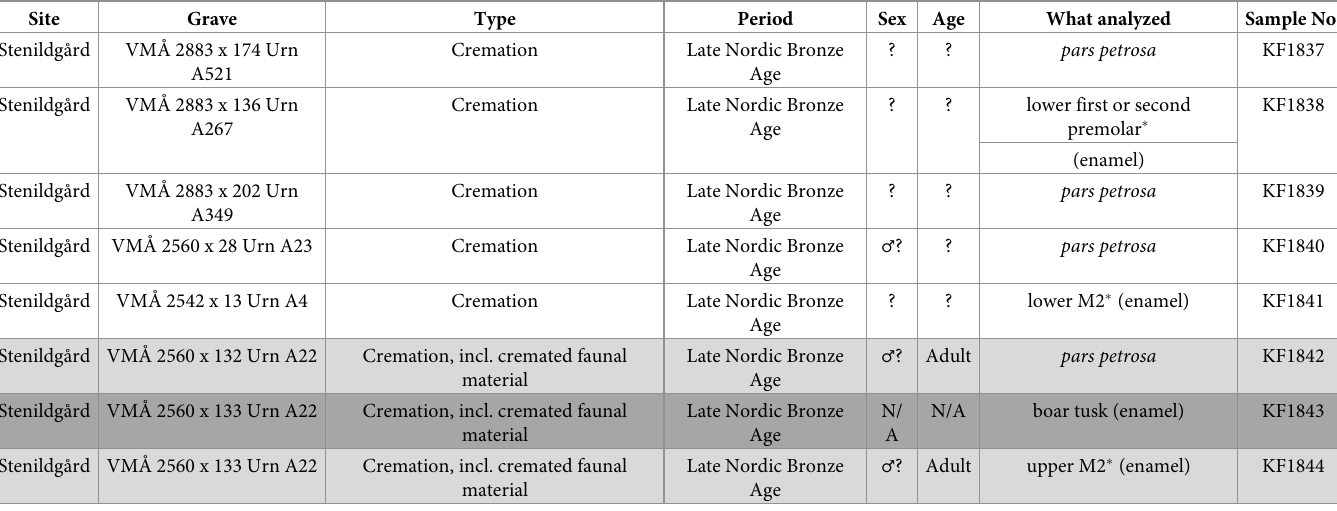
Table 5. Details of material sampled from Late Nordic Bronze Age Stenildg å rd, Vesthimmerland.